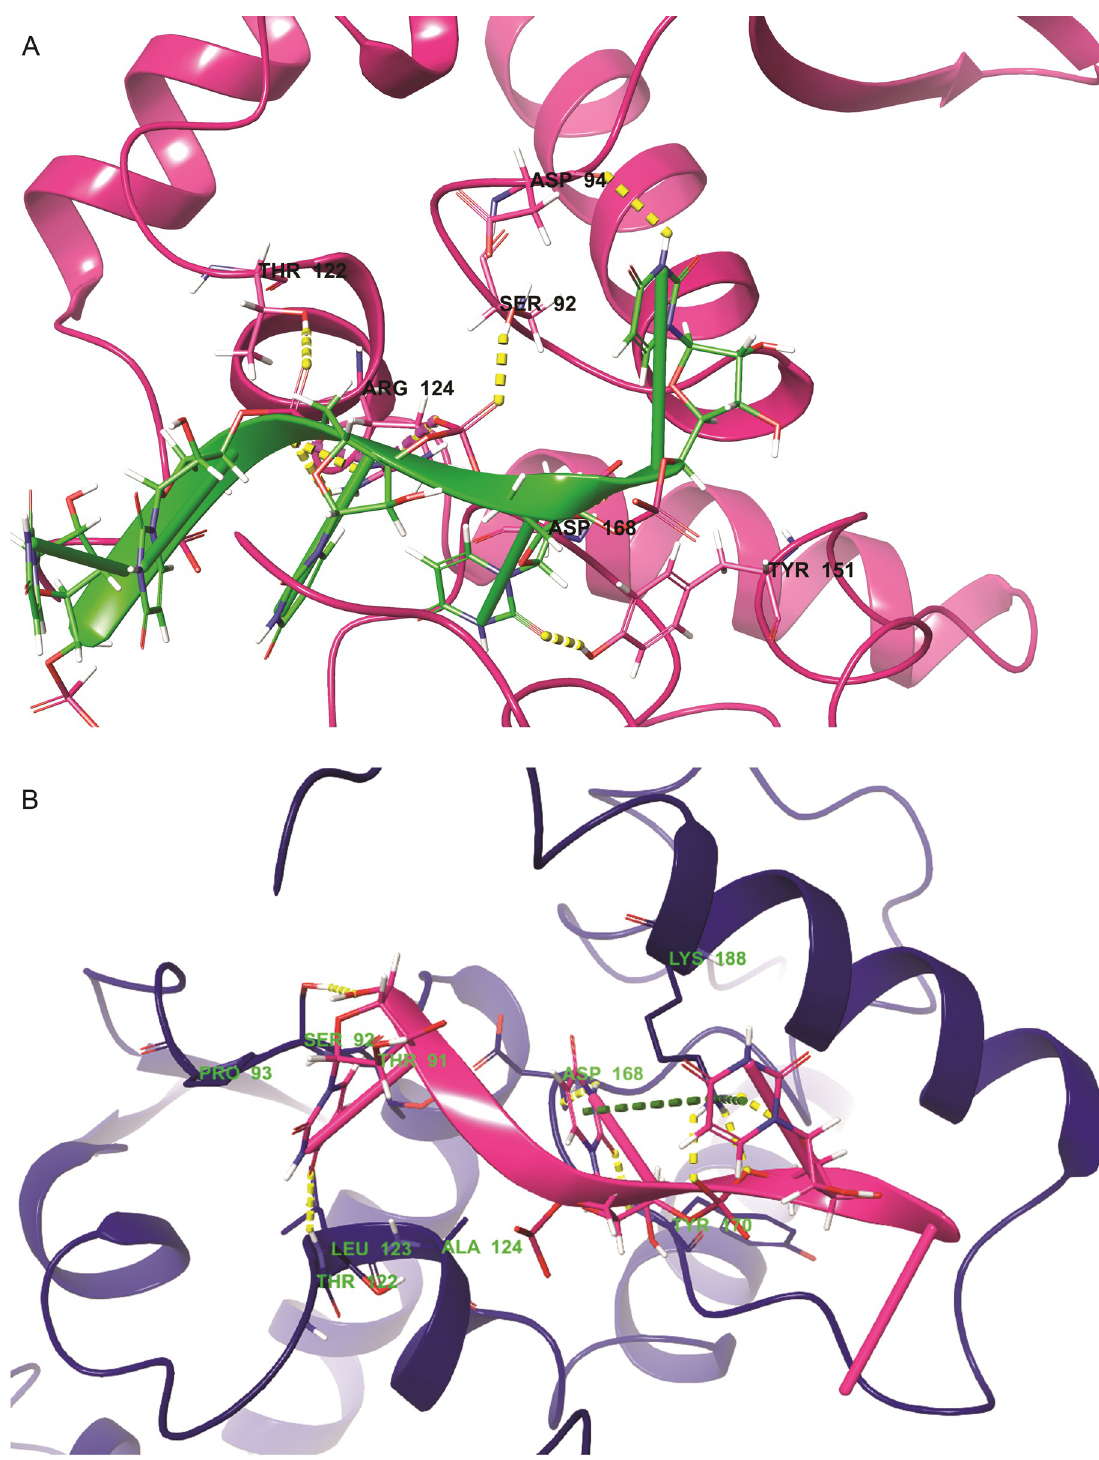
Fig 6. Interaction analysis of YBMV CP with RNA binding reorganization. (A) Wild type; (B) R124A mutant.